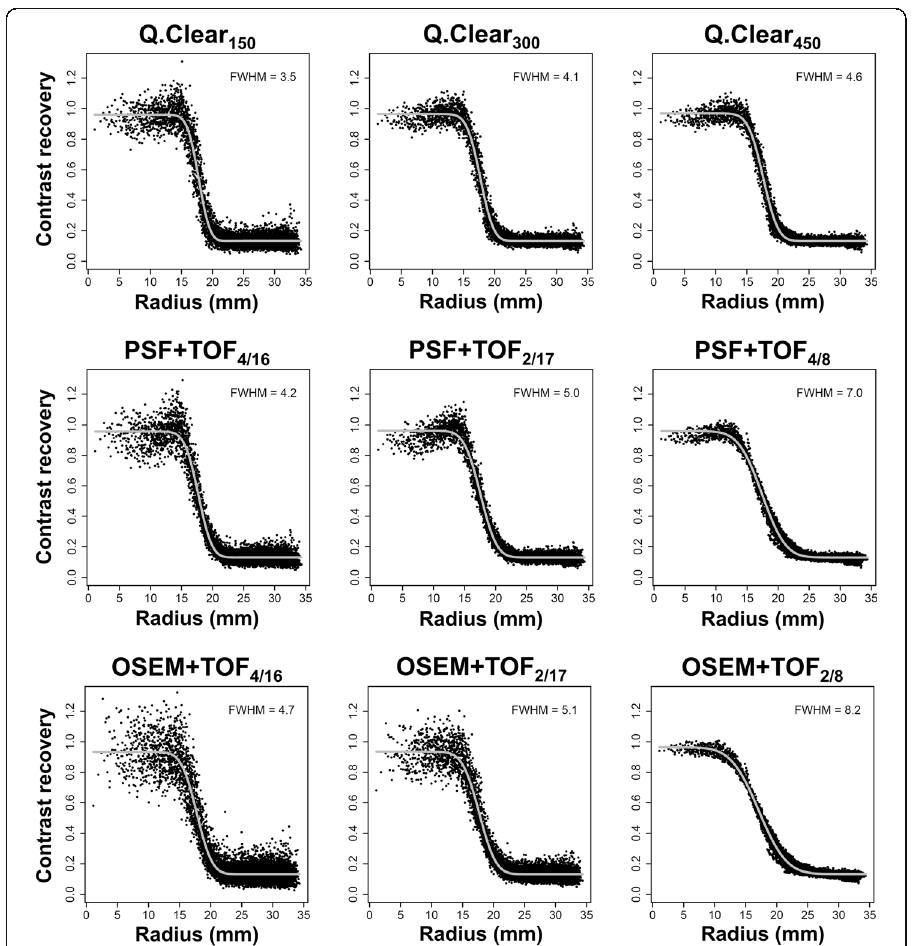
Fig. 1 Sphere activity profiles (37 mm). Radial activity profiles of the 37 mm sphere are displayed for signal- to-background ratio (SBR) 8:1 with the respective reconstructed spatial resolution (full width at half maximum,